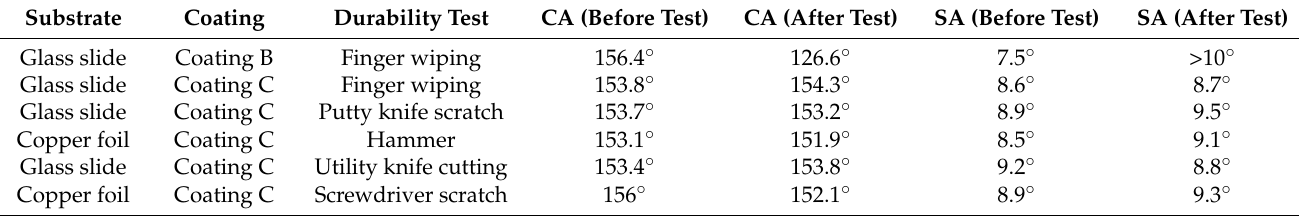
Figure 8. Mechanical durability test. ( a – c ) finger wiping test. The inset shows the change in contact angle of coating B after the same test. ( d – f ) putty knife scratch test. ( g – i ) hammer test. ( j – l ) utility knife cutting test. ( m – o ) screwdriver scratch test. Table 3. The CA and SA of coatings with different compositions after different durability tests.